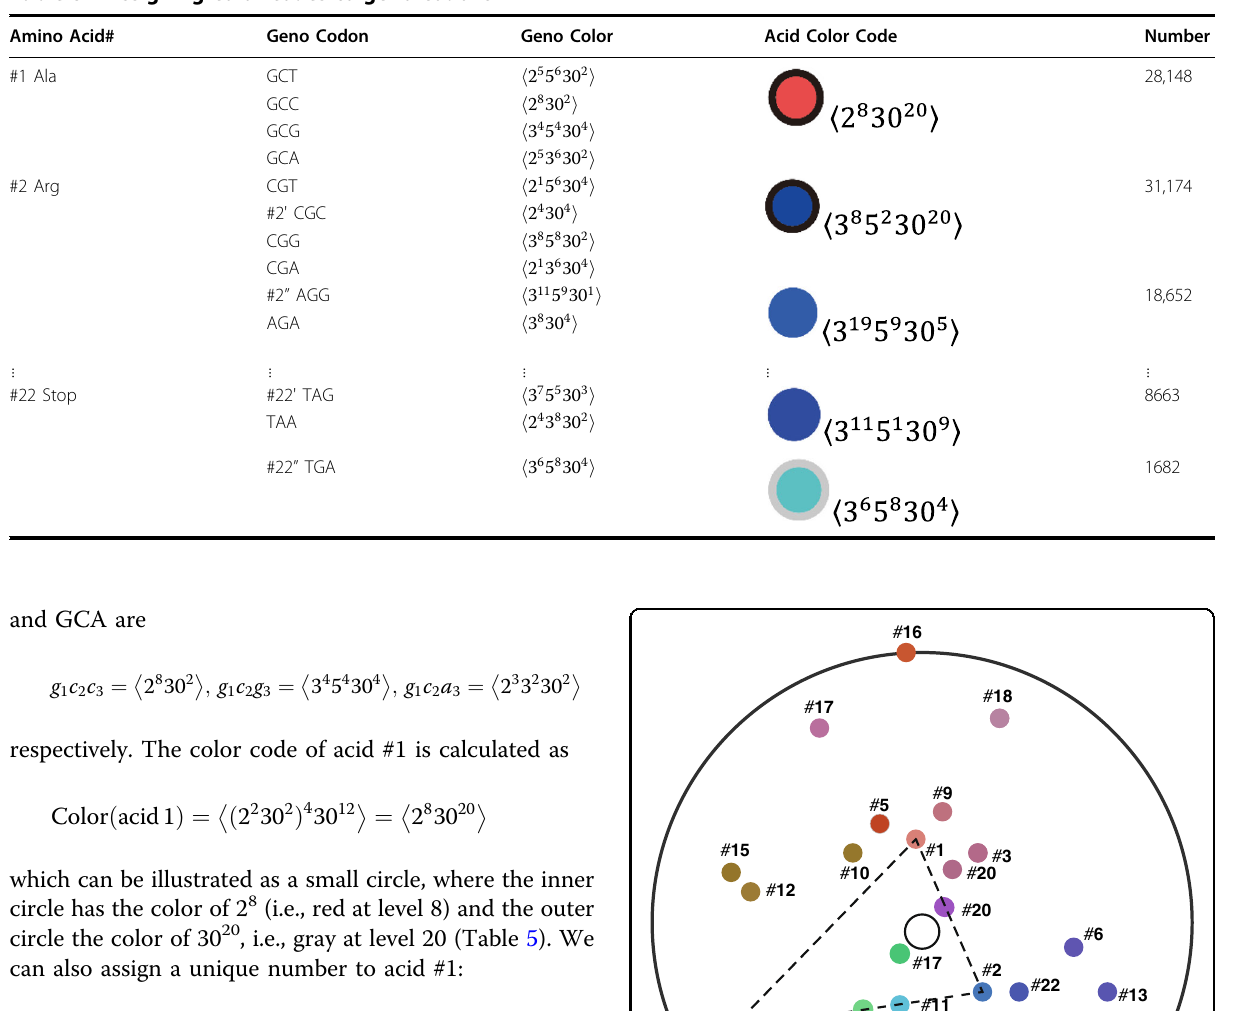
Table 5 Assigning color codes to geno codons